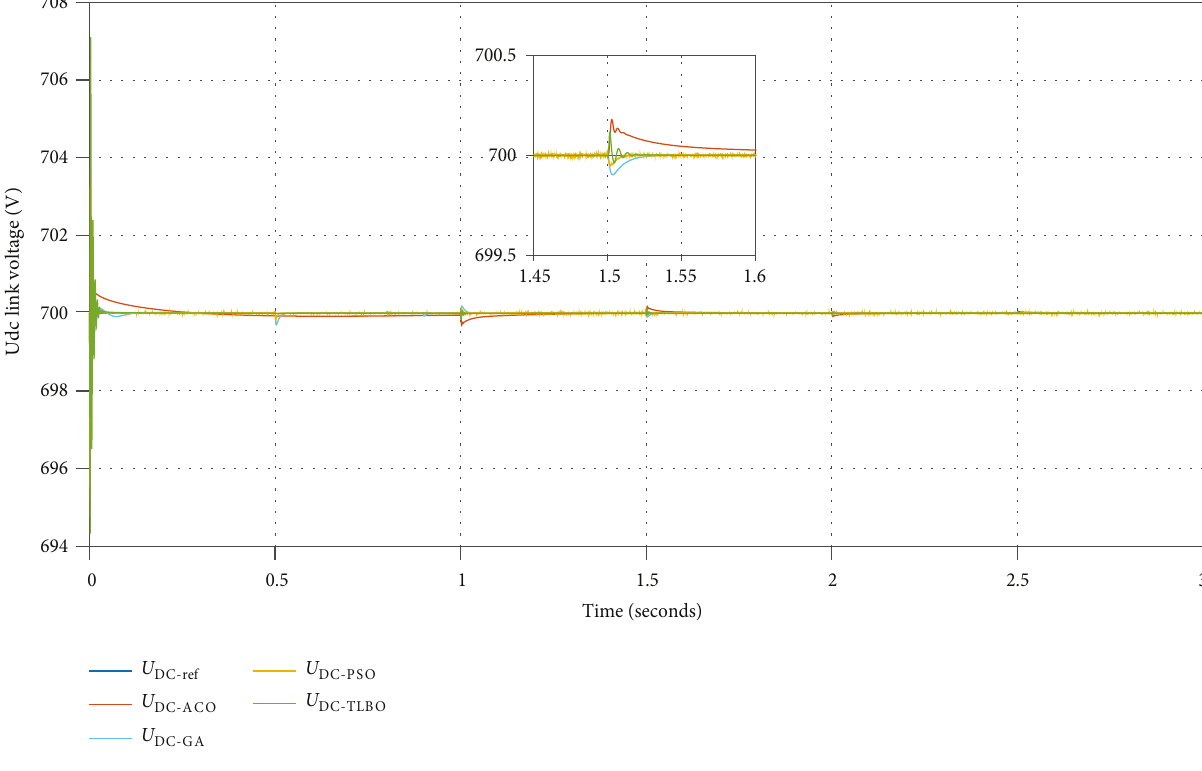
Figure 10: U dc link voltage at varying irradiation. Table 3: Controller parameters of the U